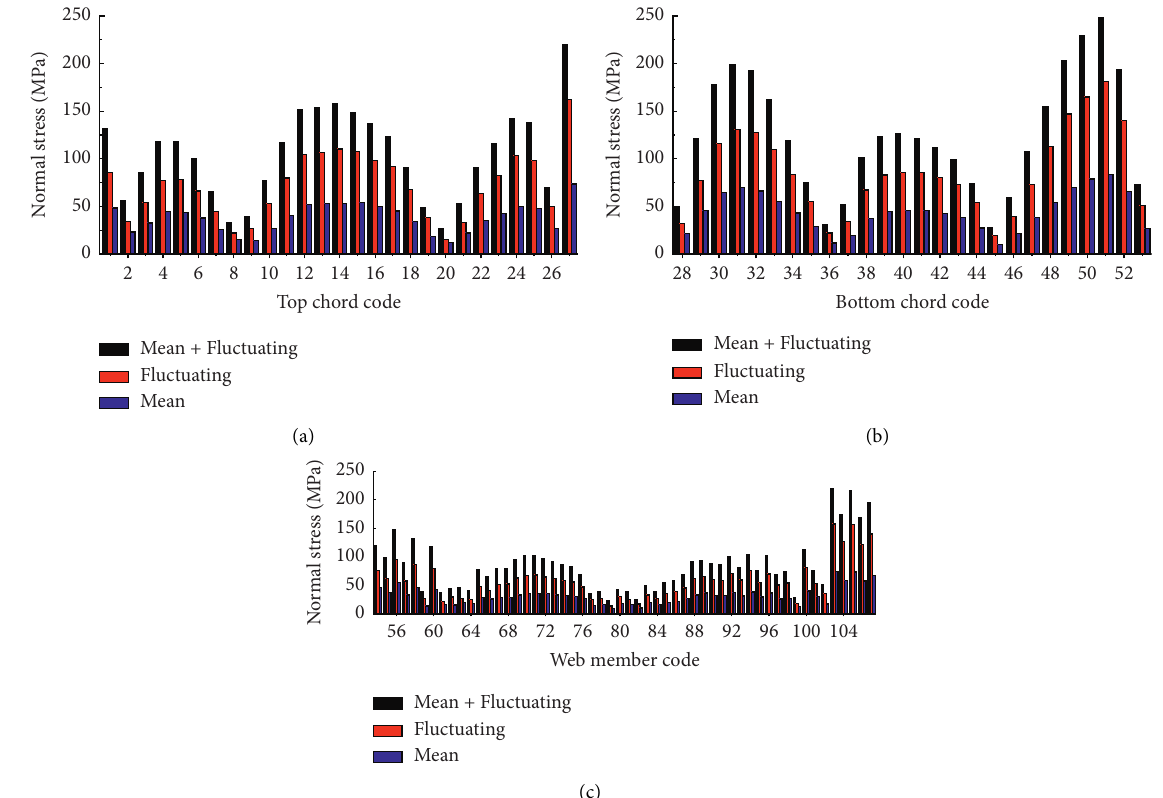
Figure 12: Distribution curve of maximum total stress at cross sections of plastic greenhouse. (a) Top chord. (b) Bottom chord. (c) Web member. Table 2: Comparison of total stress at cross sections. Cross sections Total stress at cross sections for bottom chord Load Total stress at cross sections for top chord (MPa) (MPa) Mean+ Fluctuating